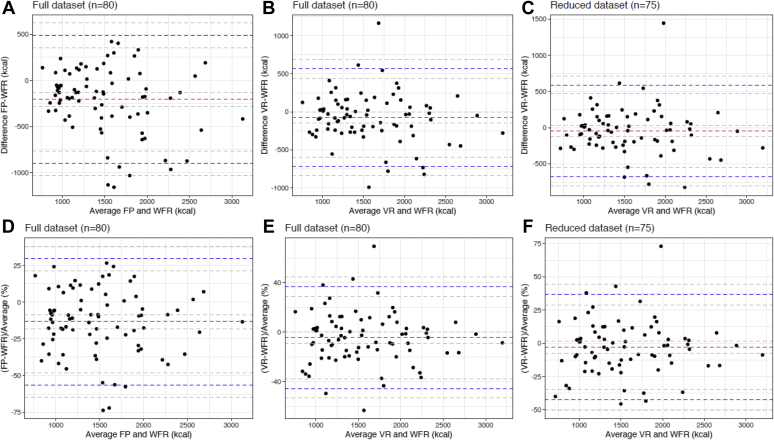
Bland-Altman plots with 95% limits of agreement between weighed food records (WFR) and (A) food photography (FP), (B) video recording (VR), and (C) video recording excluding days with missing food items for estimating actual energy intake, and between WFR and (D) FP, (E) VR, and (F) video recording excluding days with missing food items for estimating percentage of energy intake in 80 free-living adults over 2 days in Glasgow, UK, between January and August 2016. Red dashed lines are the mean estimation differences between the 2 methods, blue dashed lines represent the upper and lower 95% limits of agreement and gray dashed lines represent their associated 95% CIs.